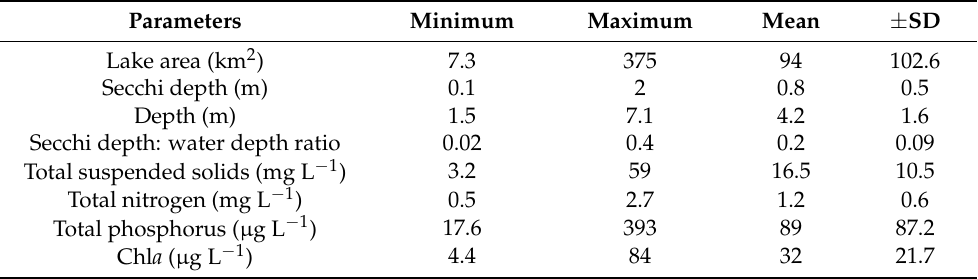
Table 1. Characteristics of the investigated lakes. SD represents the standard deviation of the sampling lakes. Chl a , chlorophyll a concentration in phytoplankton. Parameters